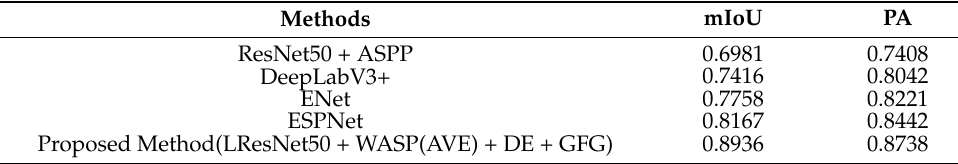
Table 8. Comparison of quantitative results using Satellite dataset II (East